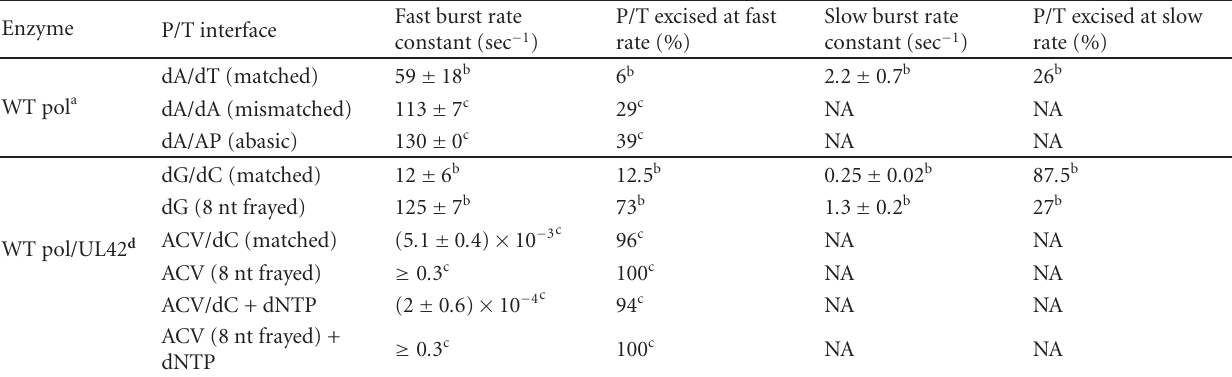
Table 2: Summary of presteady-state kinetics of excision by wild-type HSV-1 polymerase.